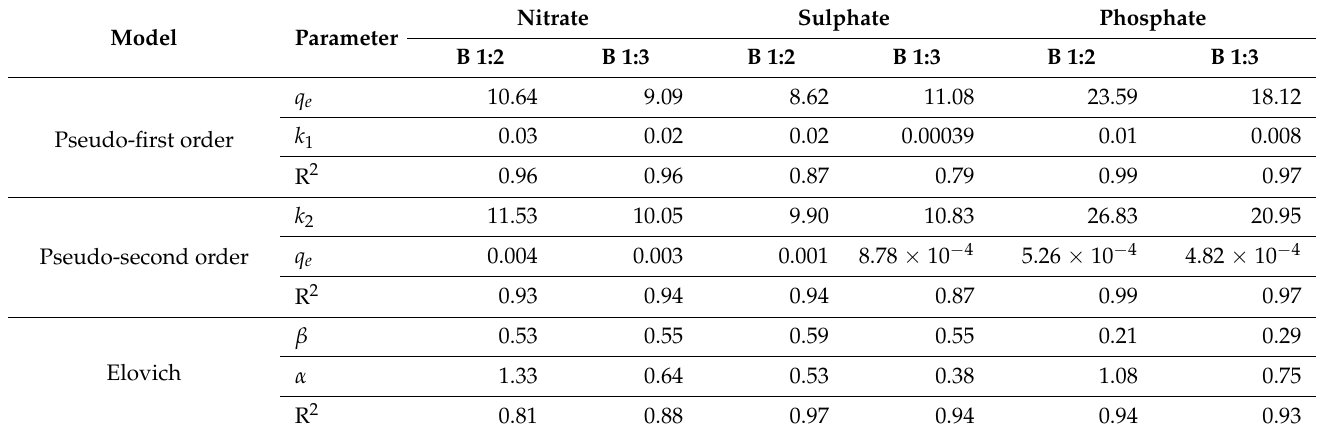
Figure 1. Adsorption kinetics of ( a ) nitrate, ( b ) sulphate and ( c ) phosphate; source: own study. Table 1. Adsorption kinetic parameters of nitrate, sulphate, and